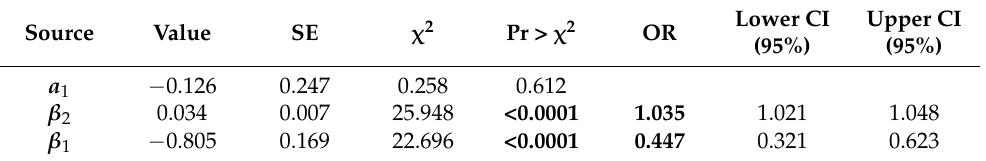
Table 7. The parameters of the logistic model characterizing the relationship between the variable Y 2 : “Have you taken any COVID-19 treatment?” and the variables X 1 and Z 1 (Model 3). Bold values indicate a statistically significant